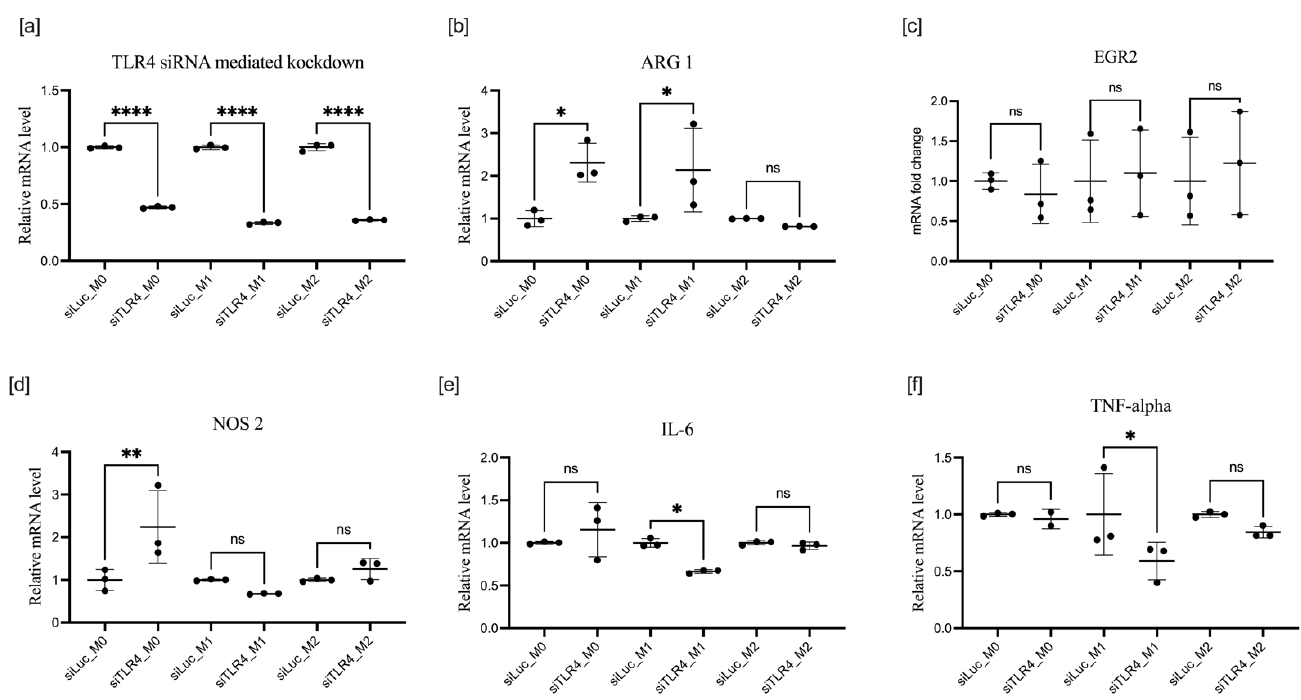
Figure 5. mRNA expression of TLR4 ( a ), ARG1 ( b ), EGR2 ( c ), NOS2 ( d ), IL-6 ( e ), and TNF- α ( f ) after TLR4 knockdown in macrophages treated according to protocol 1. Data are presented as mean ± SD, n = 3 [ns; not significant; * p < 0.05; ** p < 0.01; **** p < 0.0001].